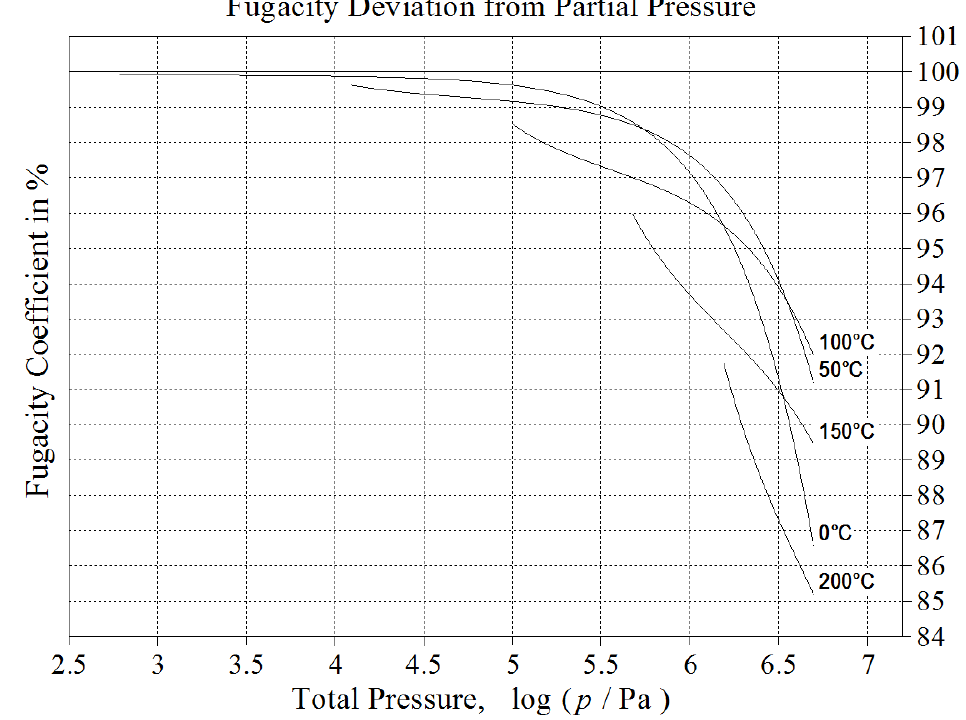
Figure 11. The fugacity coefficient, Equation 22, of water vapour in saturated air at different temperatures and pressures, calculated using a virial expansion of the TEOS-10 [273]. The value of 100 % corresponds to the ideal-gas approximation. Under meteorological conditions, log 10 ( p /Pa) ≤ 5, t ≤ 50 °C, deviations from the ideal-gas behaviour remain below 1